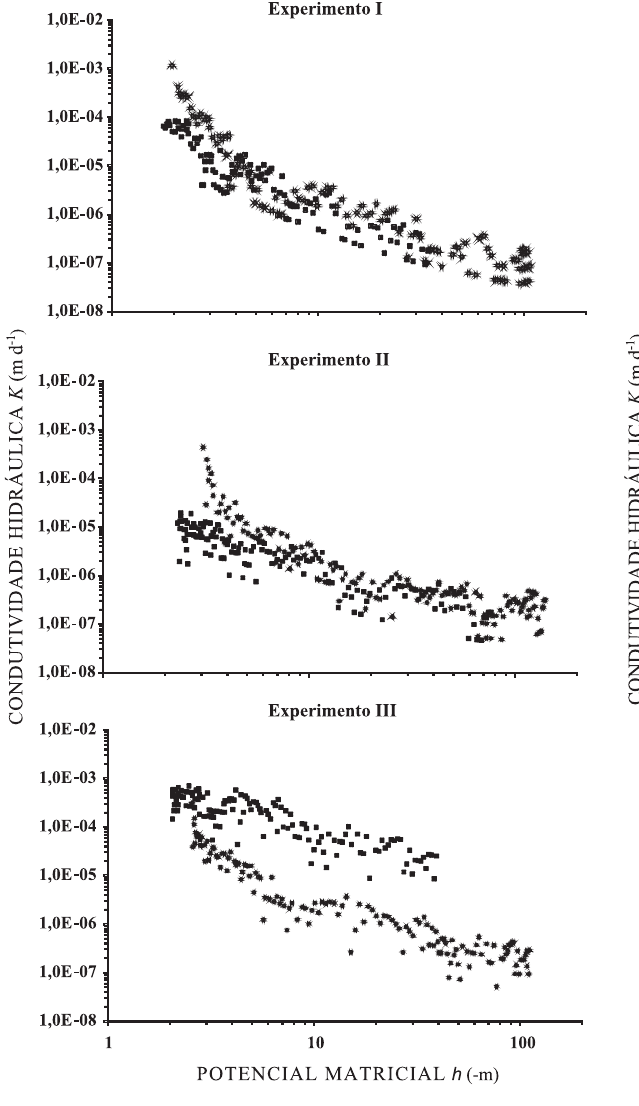
Figura 4. Condutividade hidráulica em função do teor de água para os experimentos I, II e III. Círculos representam dados obtidos entre as - z ; quadrados são dados profundidades z - z ; quadrados são dados 1 2 1 2 - z . - z ; e a linha é obtidos entre as profundidades z 2 3 2 3 a equação 7